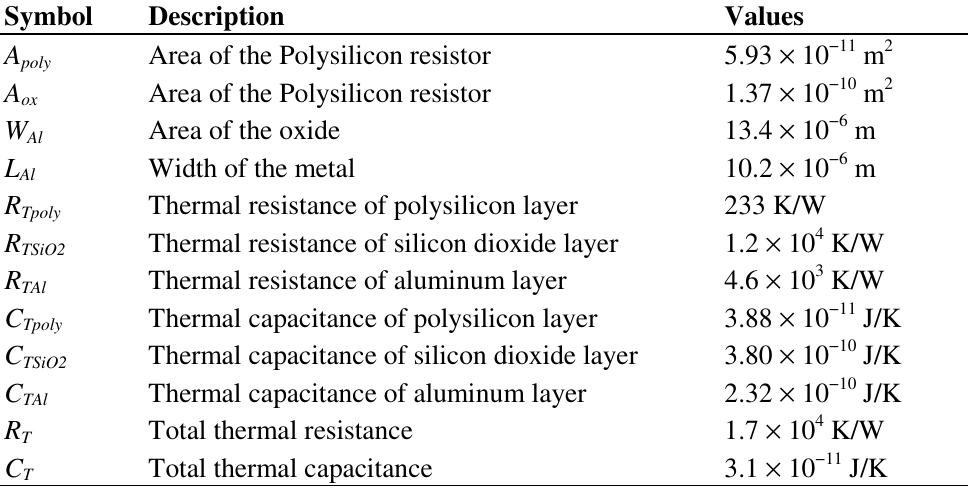
Table 3. Calculated Thermal Resistances and Capacitances.